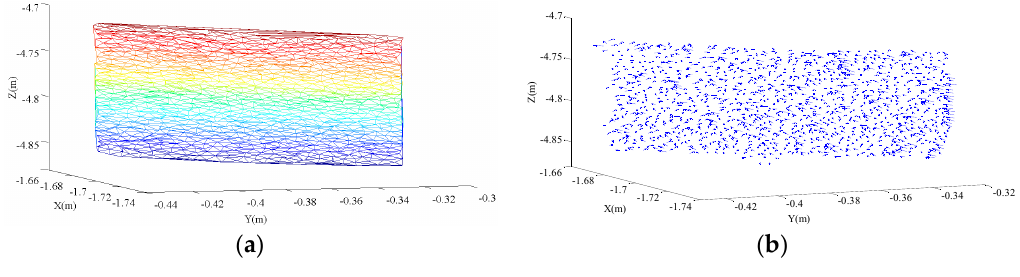
Figure 4. Triangulation and collision points’ normal vectors results. ( a ) Triangulation results; ( b ) Calculation of the collision points’ normal vectors.